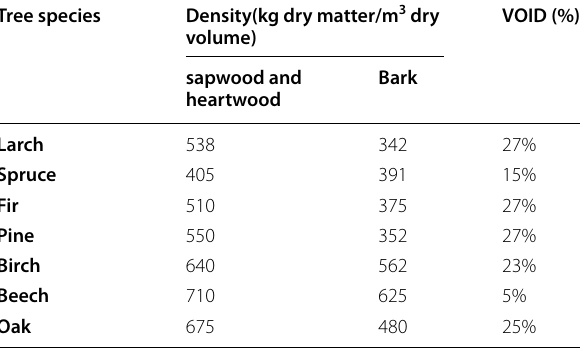
Table 6 Properties of woodbased on wood-database.com, Miles et al. (2009) and Dietz (1975). For Norway spruce, the VOID value was based on European ash (Fraxinus excelsior L.) and sessile oak (Q. petraea matt)